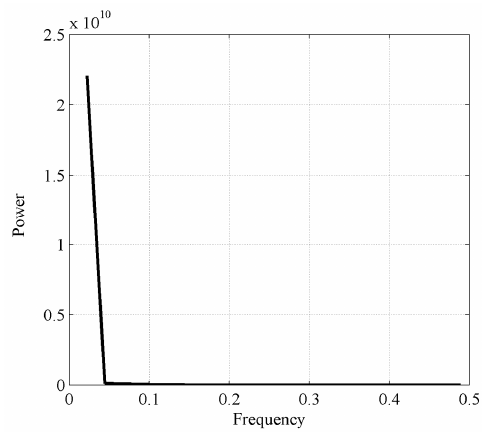
Figure 9. Power spectrum of IMF5 for Fenhe reservoir station.